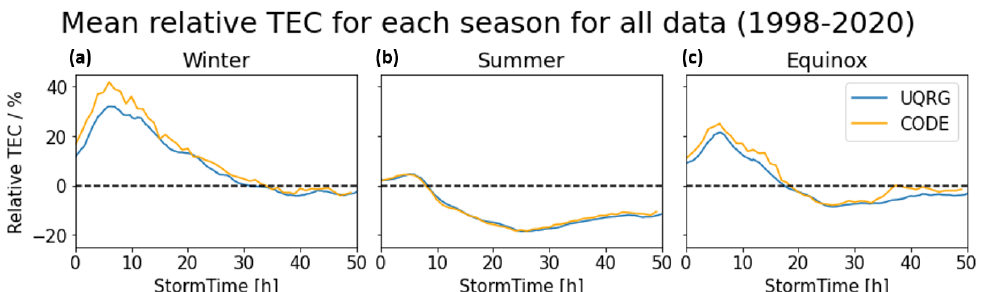
Figure 4. Comparison of the relative TEC between the UQRG from UPC and Center for Orbit Determination in Europe (CODE) GIM data as a function of storm time (averaged over the complete region) plotted for winter ( a ), summer ( b ) and equinox ( c ). The classification into seasons was performed according to the DOY listed in Table 1. Storm time equals zero corresponds to the time where the Dst index was maximum, right before it started